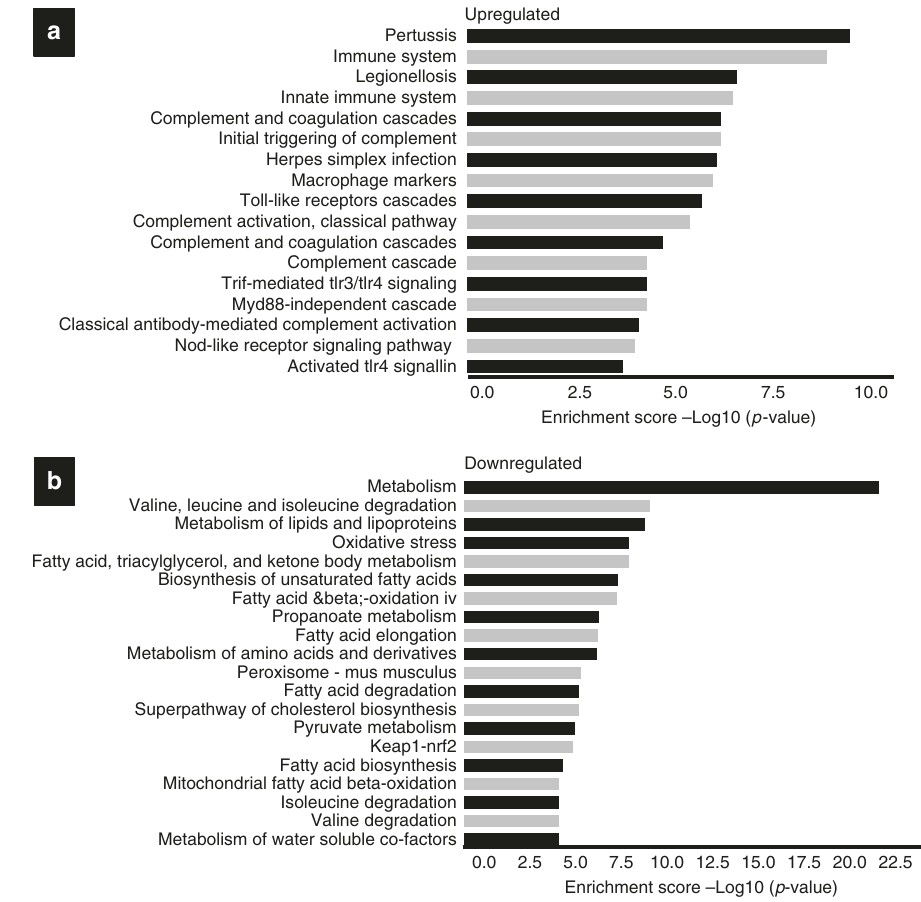
Fig. 5 Pathway enrichment analysis of Shh Cre ;Pparg fl / fl mutants compared to controls. a Over-representation analysis showing pathways that are up- regulated in the urothelium of mutants vs. controls. b Over-representation analysis showing down-regulated pathways in the urothelium of Shh Cre ;Pparg fl / fl mutants compared to control Pparg fl / fl